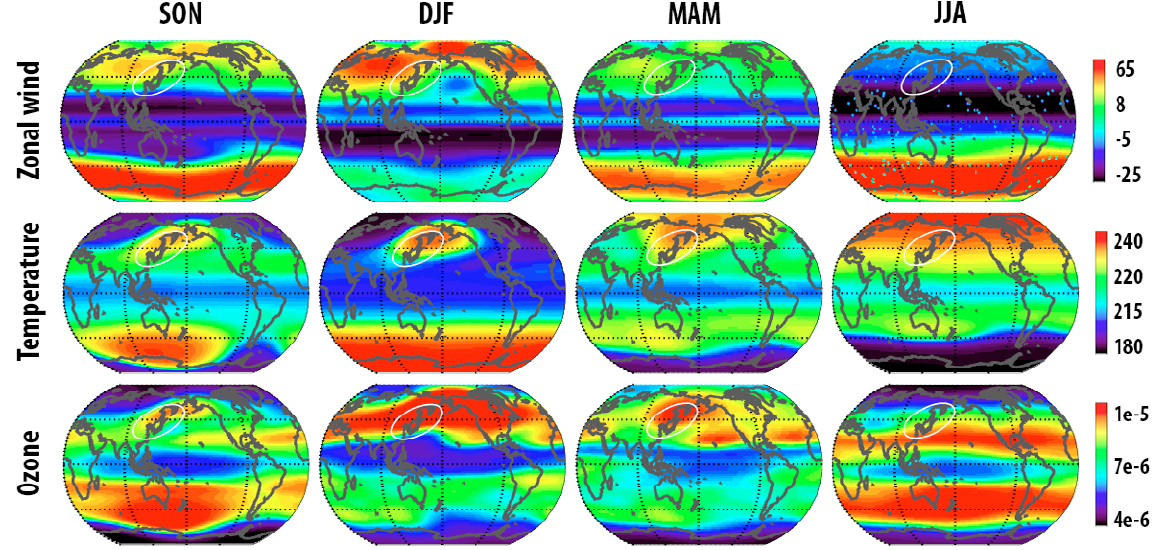
Figure 2. Seasonal averages of zonal wind in ms − 1 , temperature in K and ozone mass mixing ratio in mgkg − 1 for 1979–2013 using MERRA reanalysis (non-linear colour scale used).